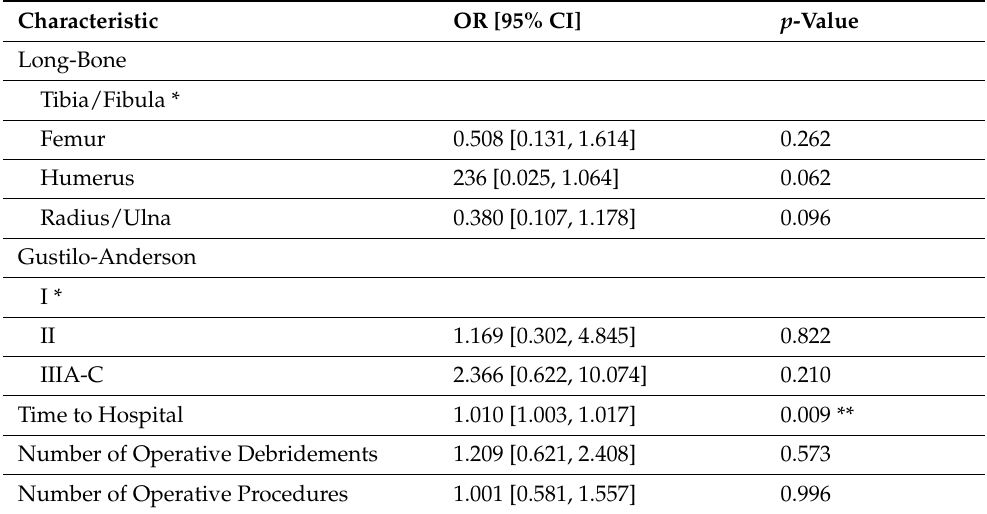
Table 5. Multivariable Analysis for Factors Associated with Developing a Deep Infection After Pediatric Open Long-Bone